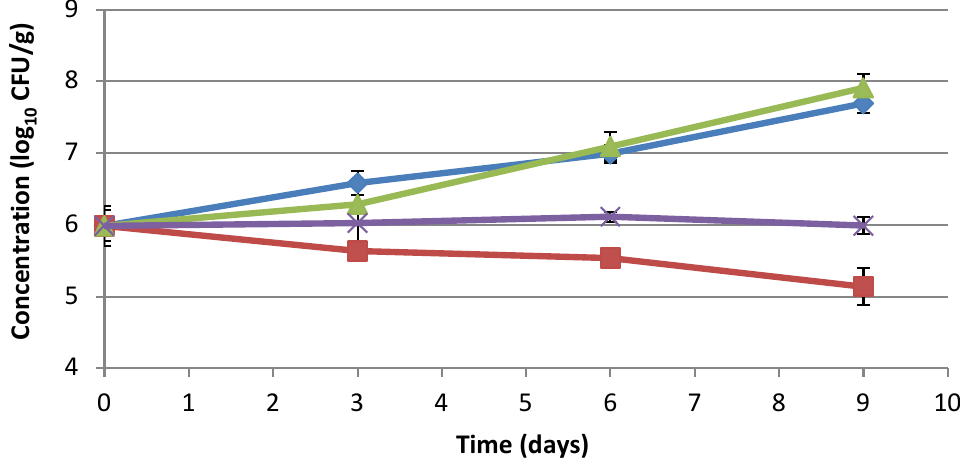
Figure 2. Effect of fermented tomato byproduct extract on Salmonella spp. in minced pork meat. Behavior of Salmonella spp. in minced pork meat with or without fermented tomato byproduct extract/preservatives determined through microbial challenge test. Salmonella spp. concentration in minced pork meat (blue line), minced pork meat with 1.6% fermented tomato byproduct extract (red line), minced pork meat with 1.2% sodium lactate (green line), and minced pork meat with 2.5% sodium lactate/sodium diacetate (96:4) (purple line). Concentration is expressed as log 10 CFU/g. A similar trend was followed by L. monocytogenes . The extract showed an inhibitory effect on L. monocytogenes after 9 days with a decrease in its concentration of 1.38 log 10